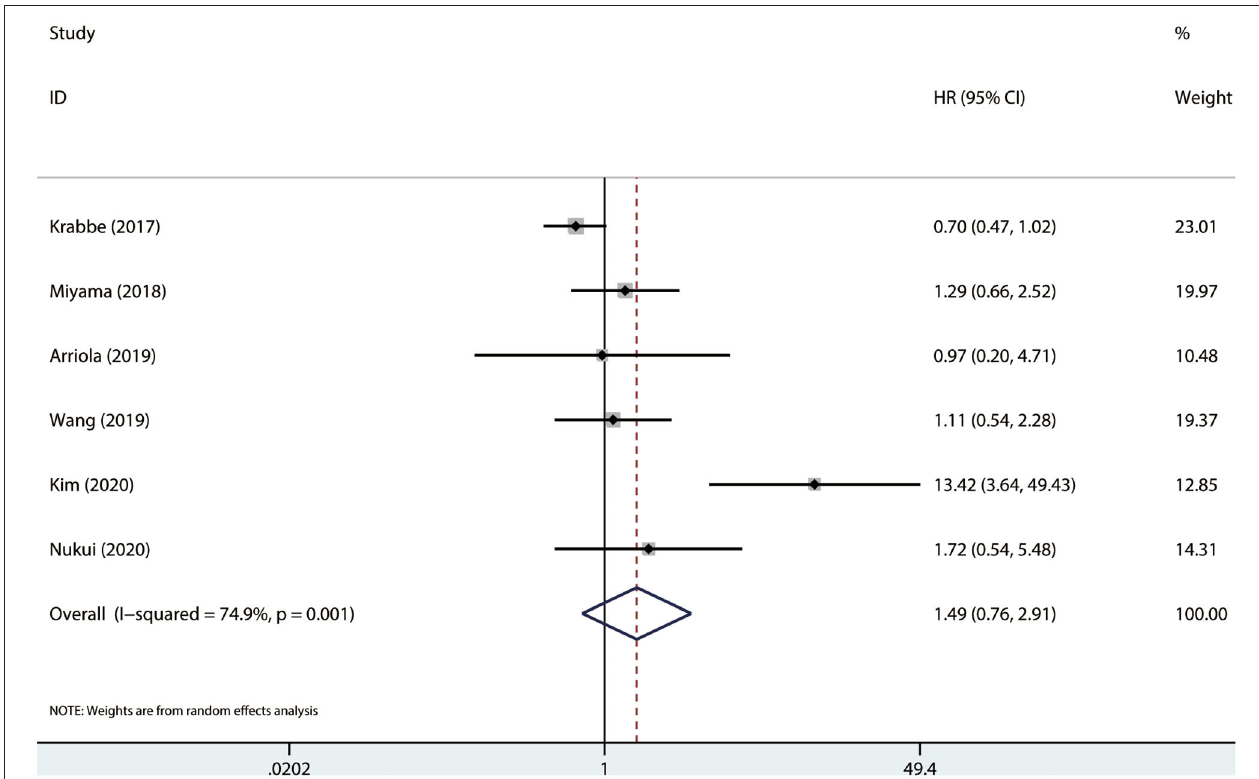
FIGURE 3 | Prognostic value of PD-L1 for OS. OS, overall survival; HR, hazard ratio; CI, confidence